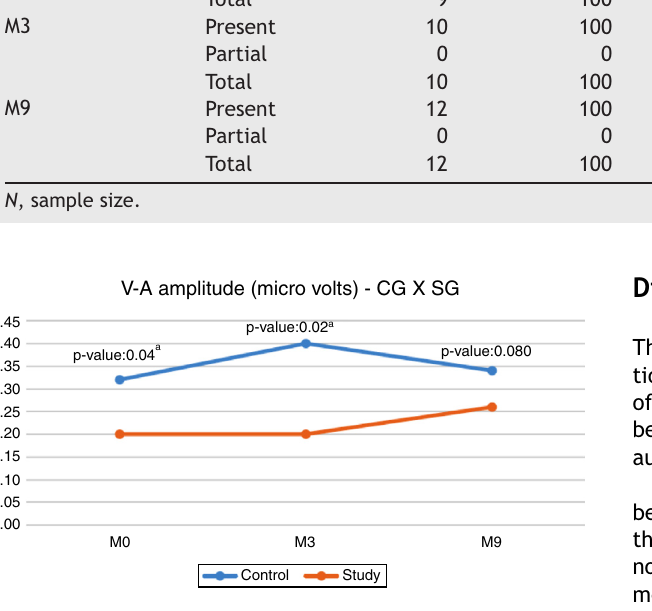
Figure 1 Comparison between the CG and the SG for V---A amplitude. a Statistical significant